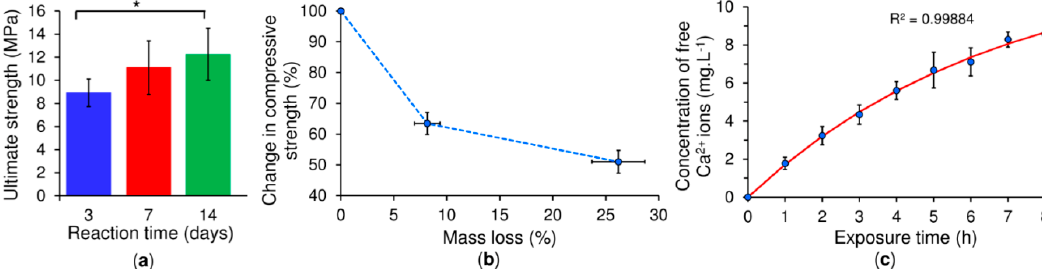
Figure 7. Results of the compression and accelerated degradation tests conducted on the 20 w/v % polymer/CPC at an L/P ratio of 0.5 g · g − 1 . Ultimate compressive strength during the reaction time of 3 to 14 days at 37 ◦ C ( a ), * denotes statistically significant differences ( p > 0.05) between the 14 day